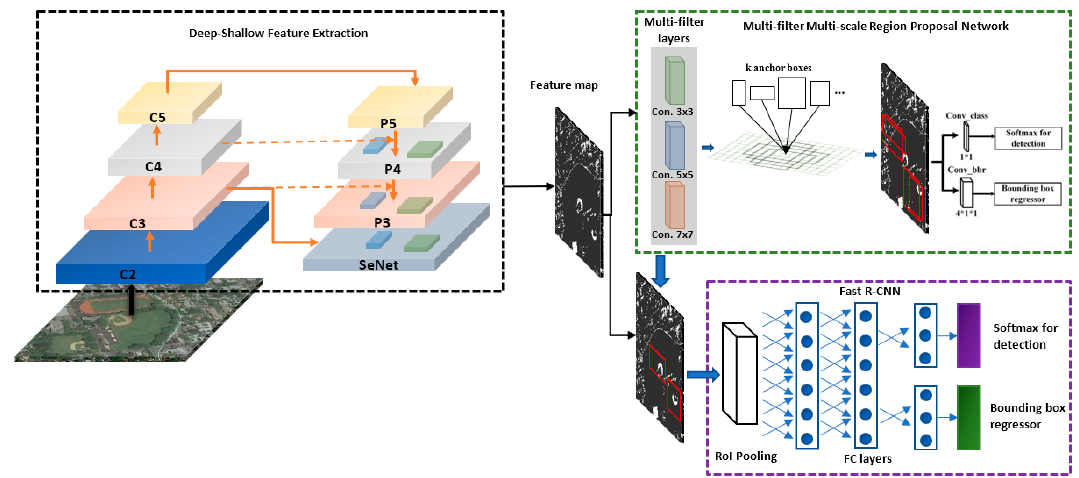
Figure 2. Shallow-deep feature extraction with the multi-filter multi-scale region proposal network (RPN) architecture.